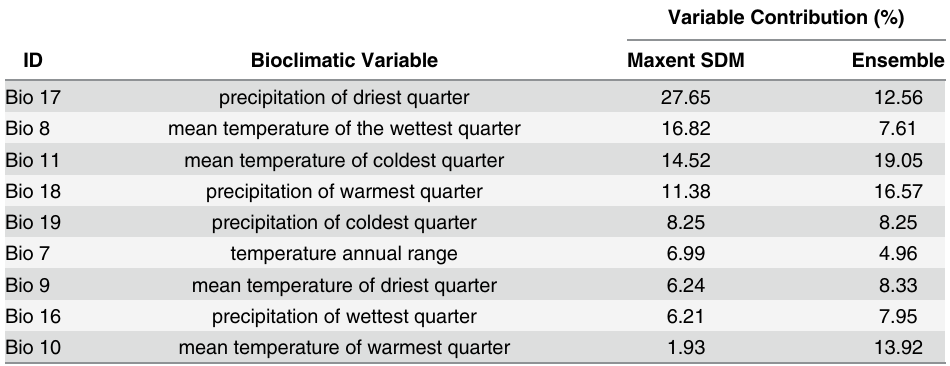
Table 1. Variable contribution for the maximum entropy and the ensemble